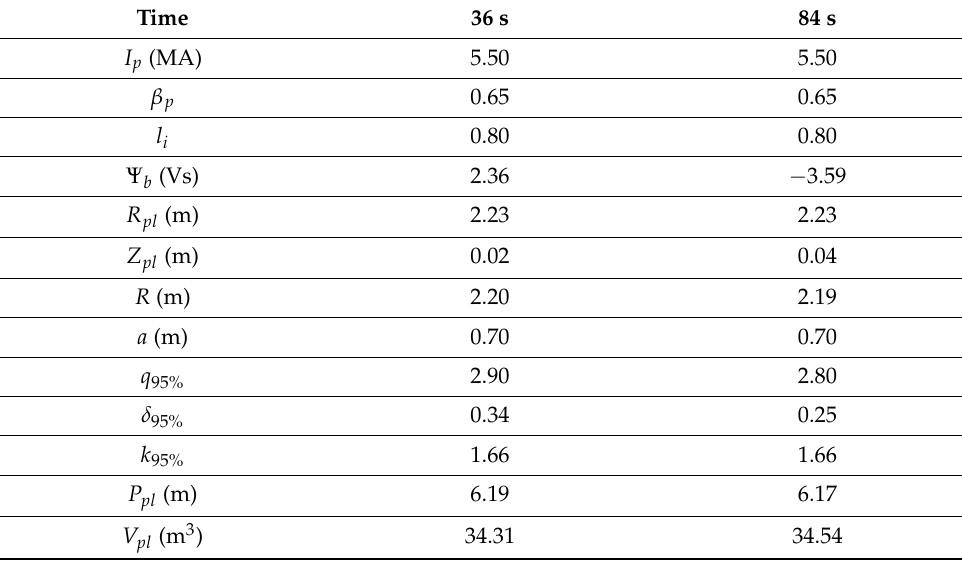
Table 6. Time evolution of main plasma parameters of the SN flat-top